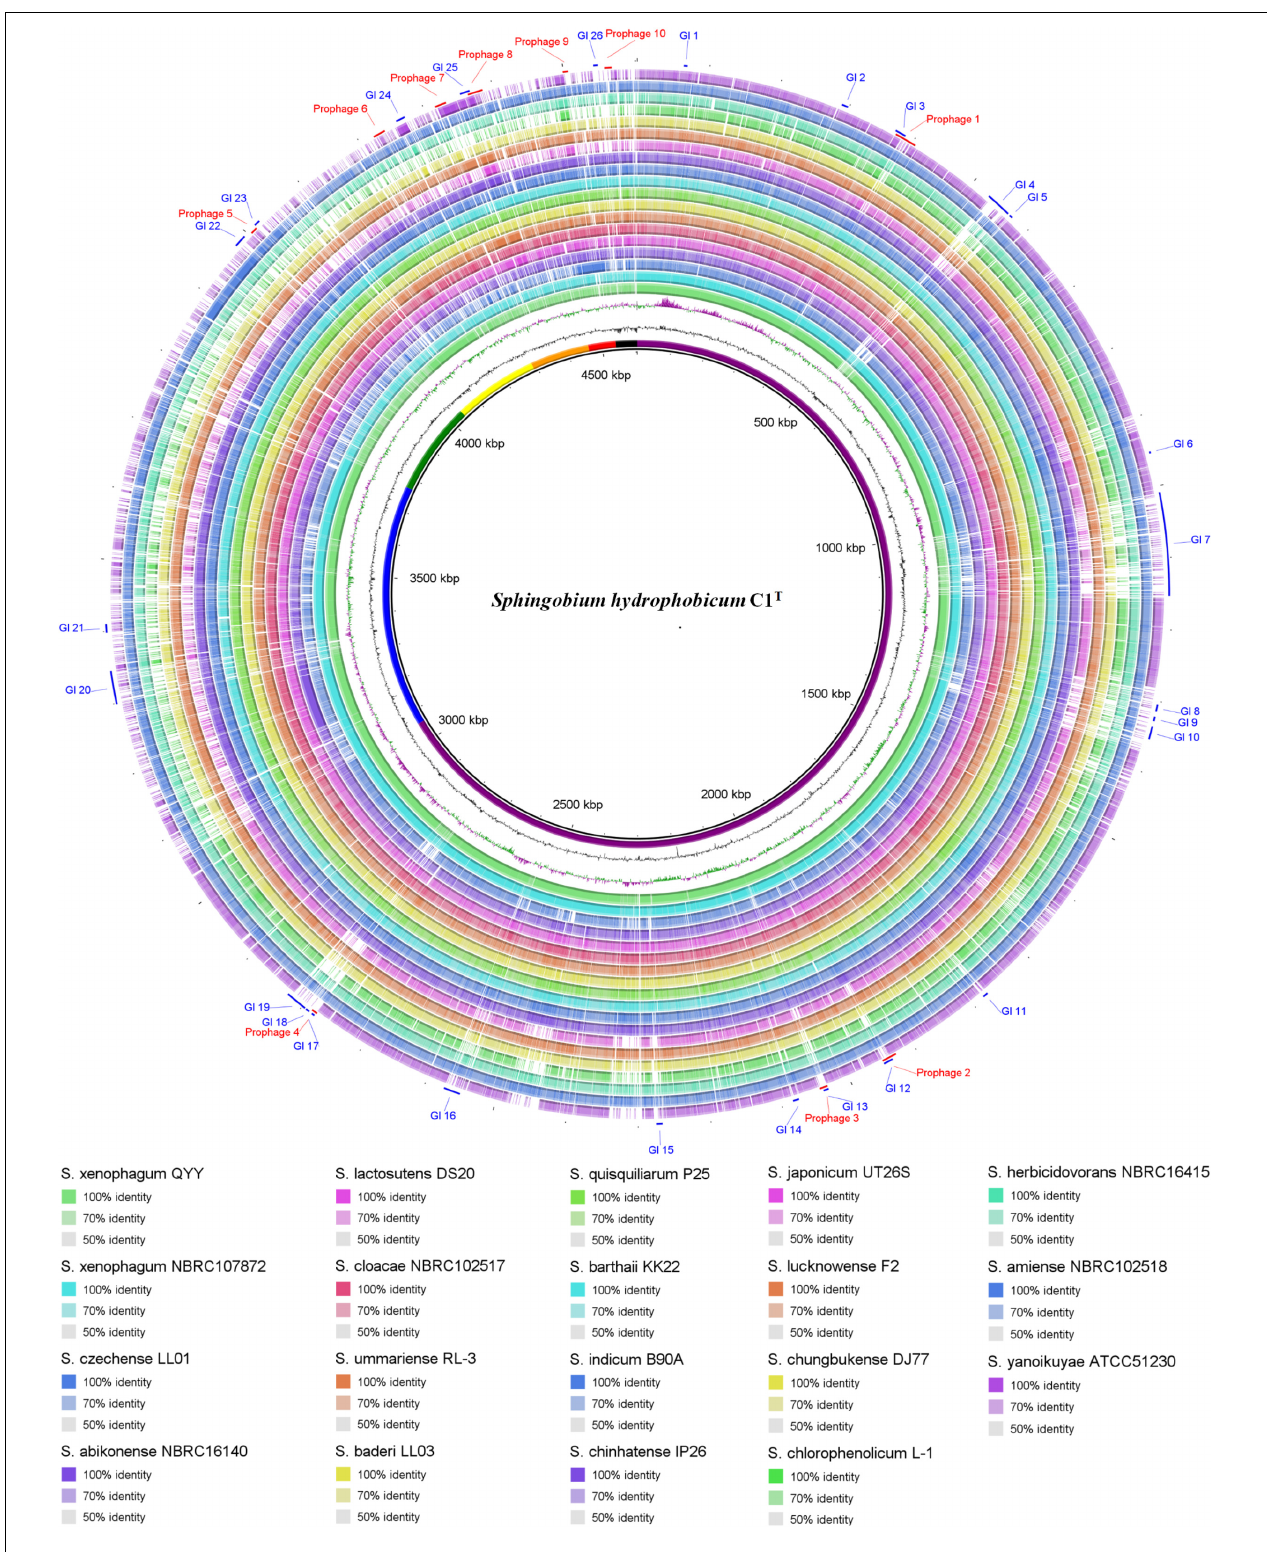
FIGURE 3 | Circular representation of the C1 T genome and comparison results with other Sphingobium genomes. From inner to outer ring: (1) Seven replicons of strain C1 T , (2) GC content, (3) GC skew, (4–21) Genome comparison (Blastn) results between strain C1 T and other Sphingobium strains listed at the bottom, (22) Prophages predicted by PHASTER, (23) GIs predicted by